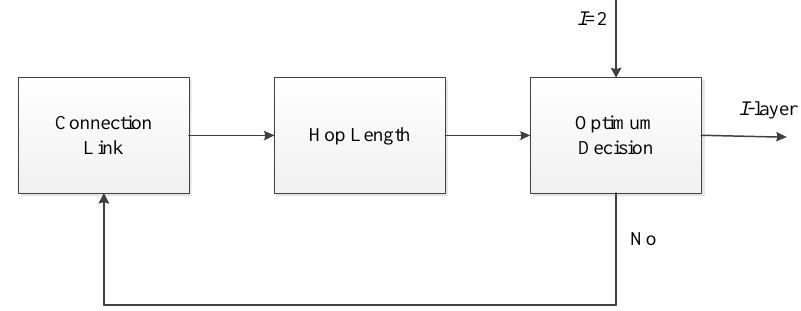
Figure 3. Block diagram of the peak-search method. I , the optimum number of layer.